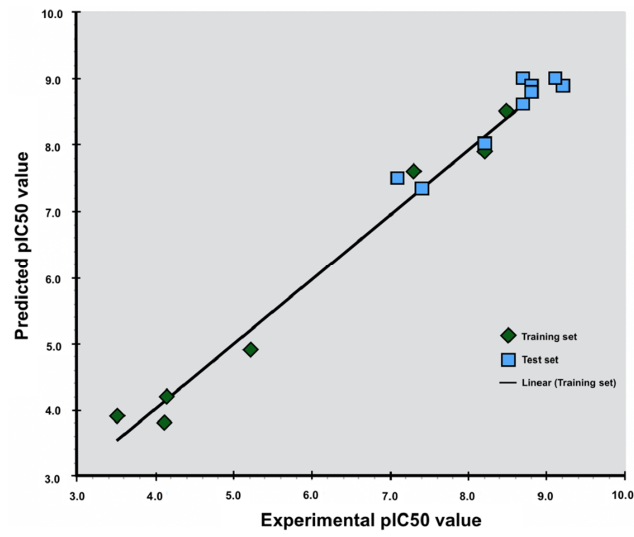
Figure 4. Scatter diagram of experimental and predicted pIC 50 values using the LIA method for agonists ( top ) and antagonists ( below ). The green squares are the ligands of the training set used to generate the parameters for predicting pIC 50 value of the ligands of the test set (blue squares).